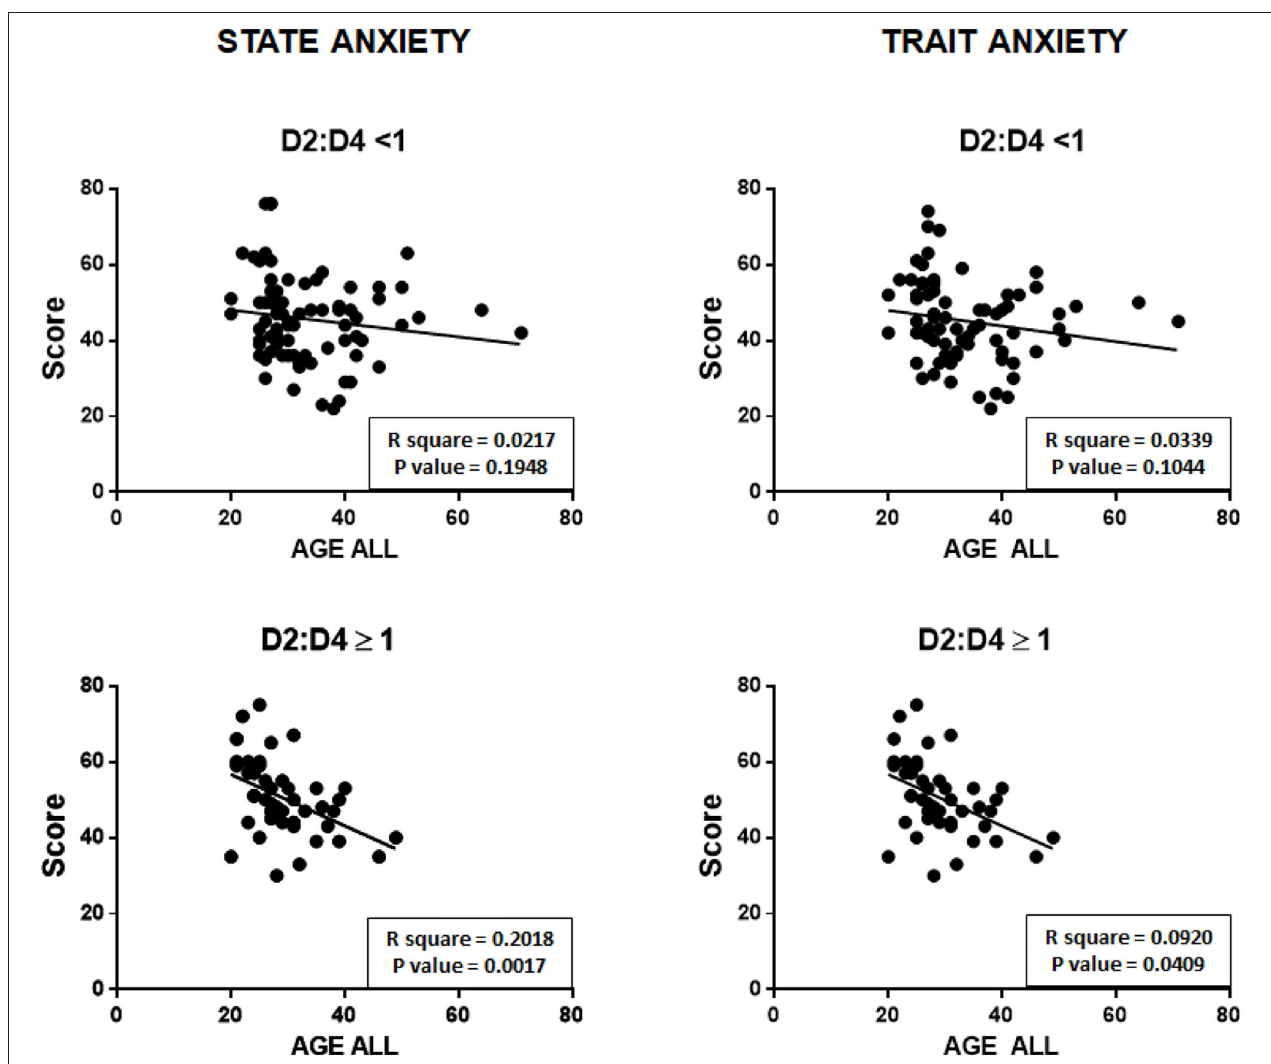
FIGURE 5 | Correlations between the ages of participants and state and trait anxiety scores of the individuals with a D2:D4 ratio ≥